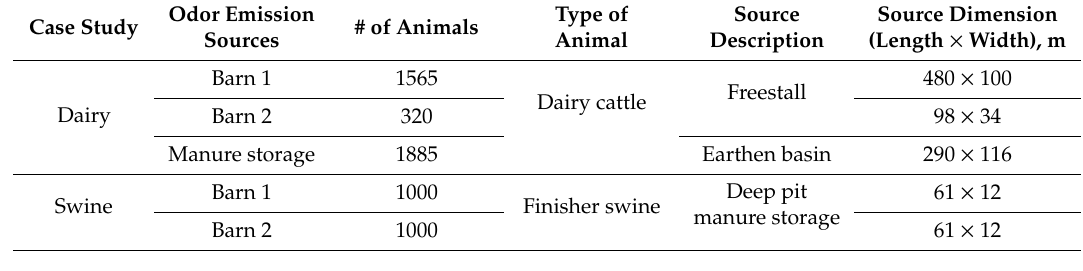
Table 1. General description of the sites.